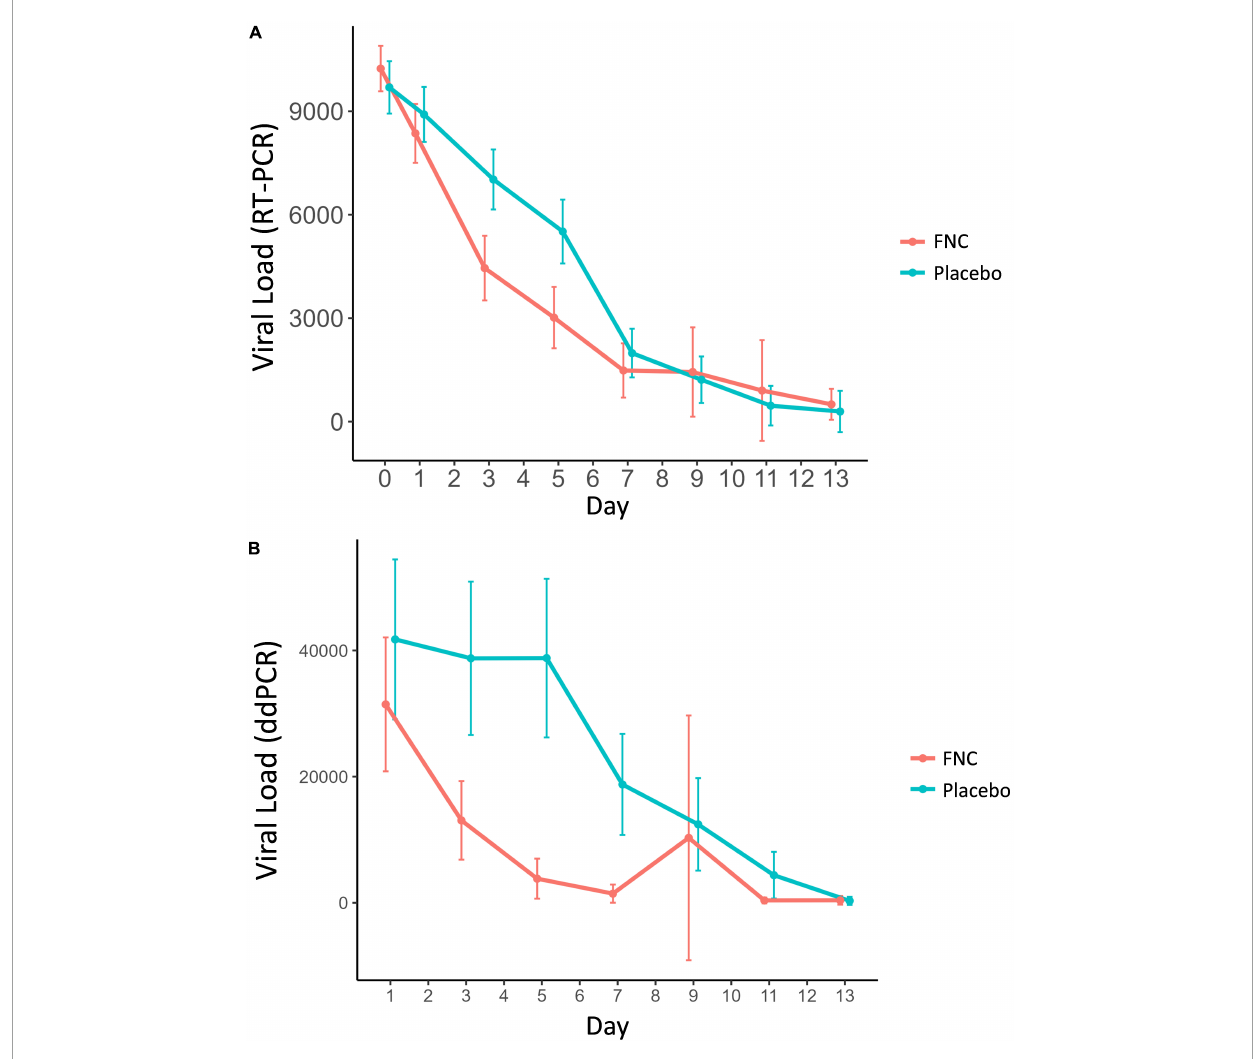
FIGURE3 Viral load analysis measured by RT-PCR (A) and DDPCR (B) of all participants in the FNC group and the placebo group. Data are median (SD) (Red line: FNC; Blue line: